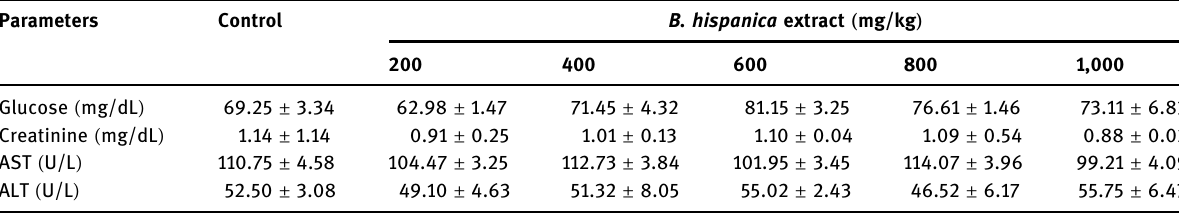
Table 4: E ff ect of B. hispanica extract on biochemical parameters in male rats under acute toxicity conditions